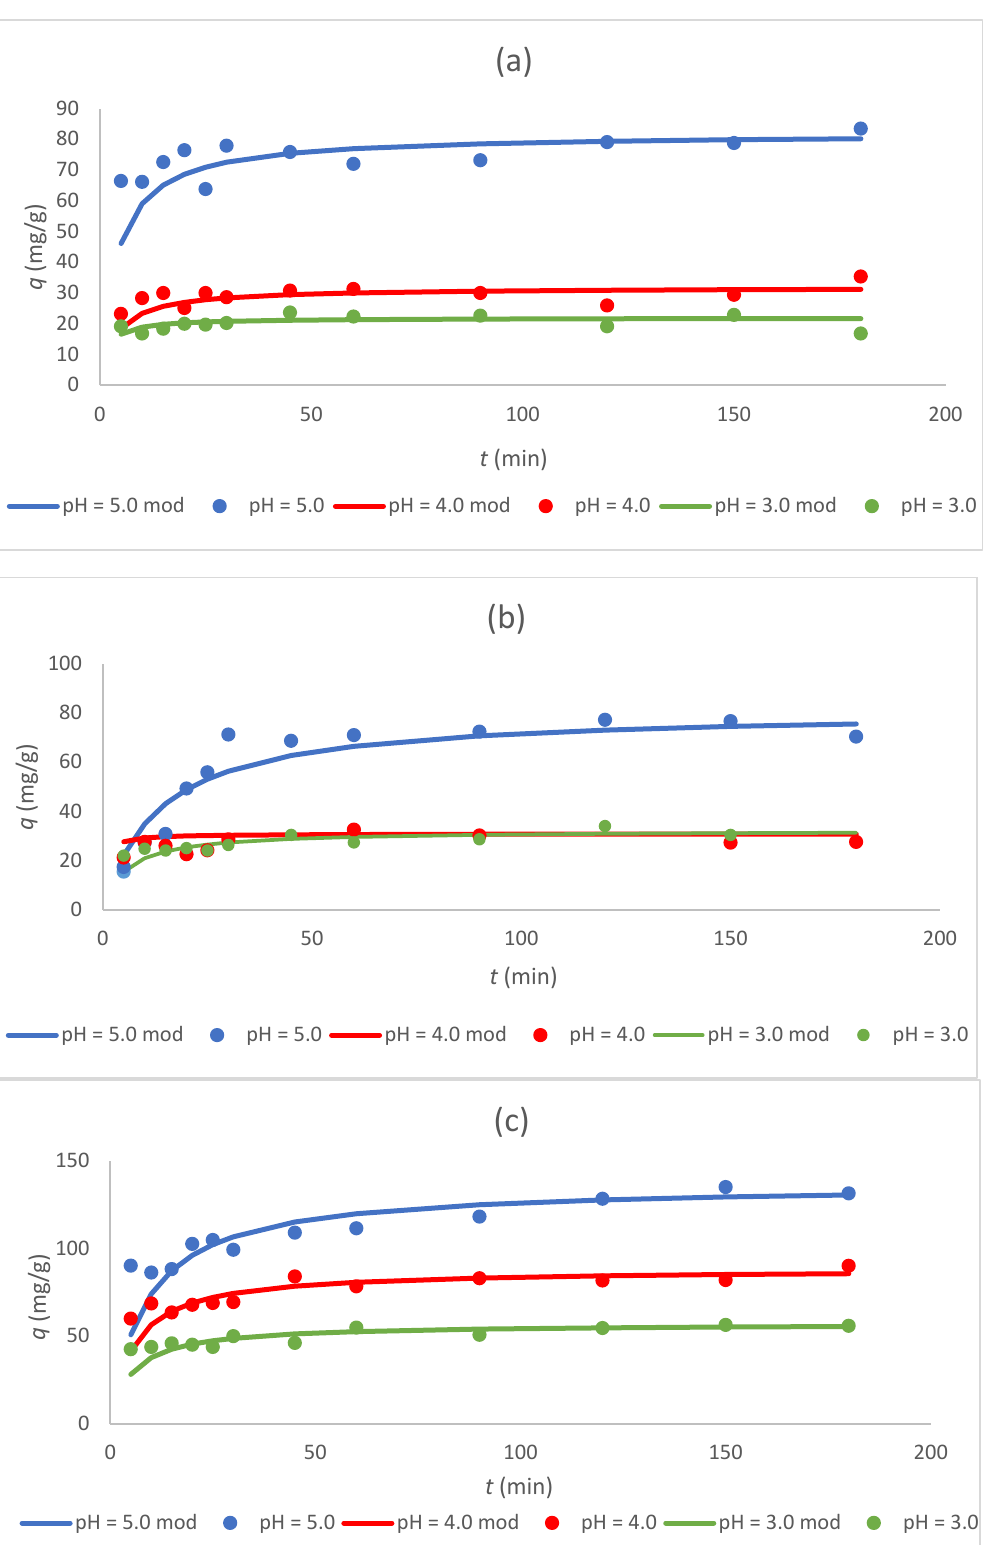
Figure 5. Dependence of the sorption capacity of the tested sorbents ( a ) Sargassum sp., ( b ) Sargassum sp. post-extraction residue, and ( c ) ZnO NPs on time for different pH values (3, 4, and 5; “mod”—model) at C 0 300 mg/L and C S 1.0 g/L.